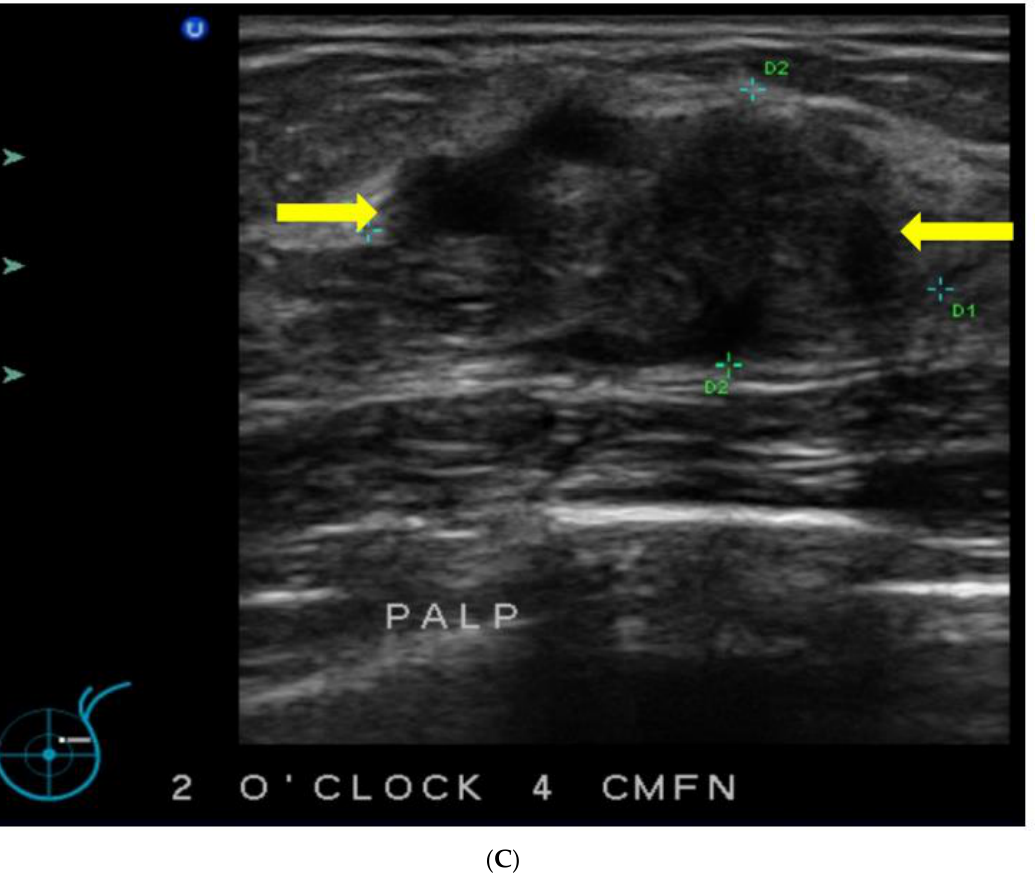
Figure 2. ( A ) Routine screening mammogram in a 50-year-old woman with screening Density Category D. Calcifications were seen in the left upper inner quadrant (not shown) for which stereotactic core biopsy showed atypical ductal hyperplasia. Surgical excision was planned. Eight months later she returned with a palpable lump in the left upper outer quadrant. ( B ) Left mammography was performed with a triangular skin marker taped at the site of the lump. The post biopsy marker clip was seen (arrow), but no abnormality was seen at the site of the lump on full field digital mammography (FFDM) or on digital breast tomosynthesis (not shown). ( C ) Ultrasound showed a 3.2 cm mass (arrows) and abnormal axillary nodes (not shown). Core biopsy confirmed invasive ductal carcinoma. This is an interval cancer.